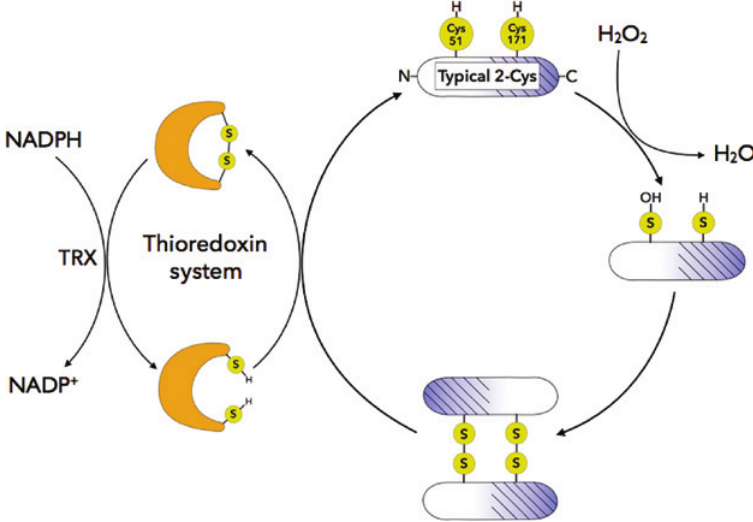
Figure 3: Antioxidant activity of typical 2-Cys peroxiredoxin. Reduction of hydrogen peroxide occurs through a sulphenic acid intermediate forming an intermolecular disulphide bond with the resolv- ing cysteine of the -CXXC- motif on the other subunit. The disulphide bond is then reduced by the Trx system, using NADPH as a cofactor, recycling the